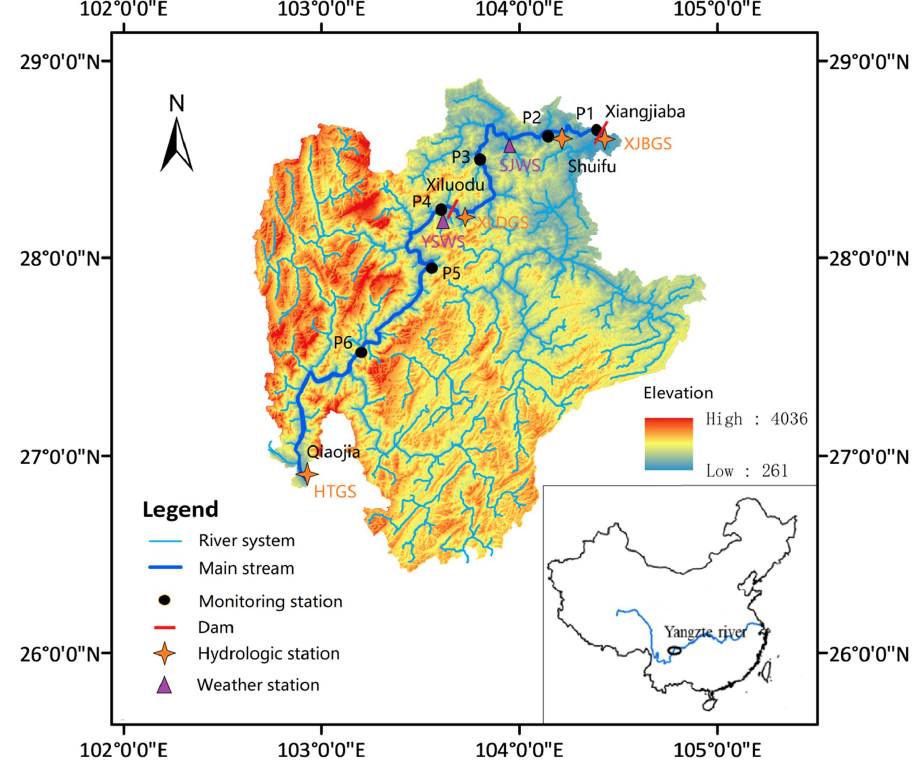
Figure 1. Map of the lower Jinsha River (black solid line, the flow direction is from south to north) with major tributaries (thin black lines). The inset shows the location of the main map within the Yangtze River basin (blue line) in China (not to scale). Symbols mark the location of the Xiluodu and Xiangjiaba dams, as well as the location of Suijiang weather stations (SJWS) and Yongshan weather station (YSWS), hydrological stations (XJBGS, PSGS, XLDGS, HTGS, see Table S1 for details) and sampling points for field monitoring (P1–P6).